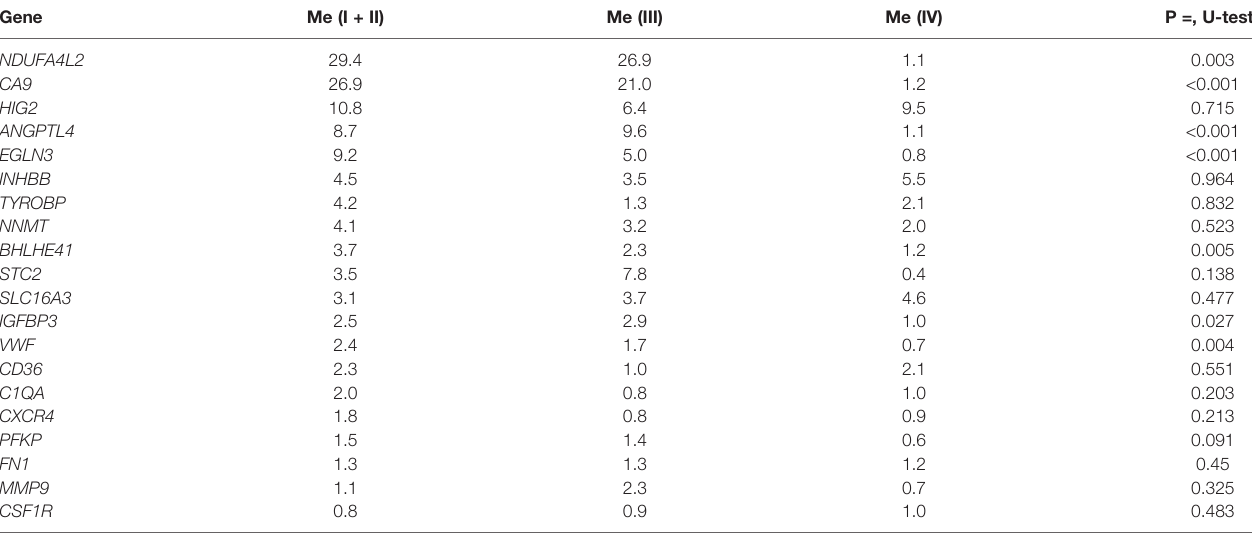
TABLE 2 | Gene expression levels and the signi fi cance of their differences at different stages of ccRCC development. Gene Me (I + II) Me (III) Me (IV) P =, U-test* NDUFA4L2